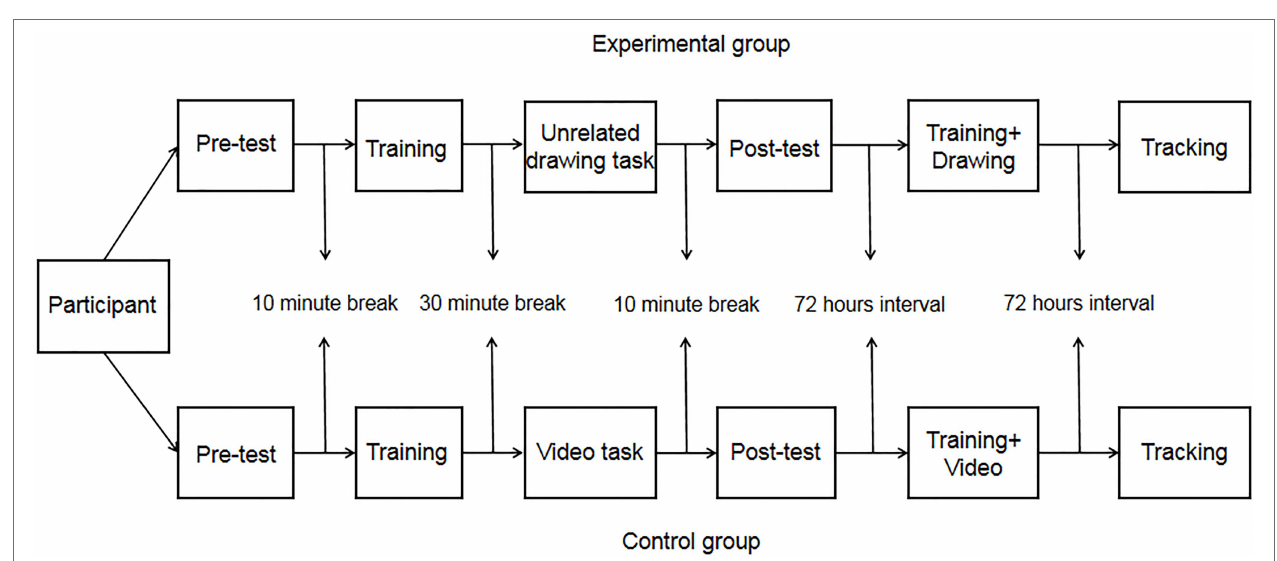
FIGURE 6 | Experimental flow chart of Experiment 2b.